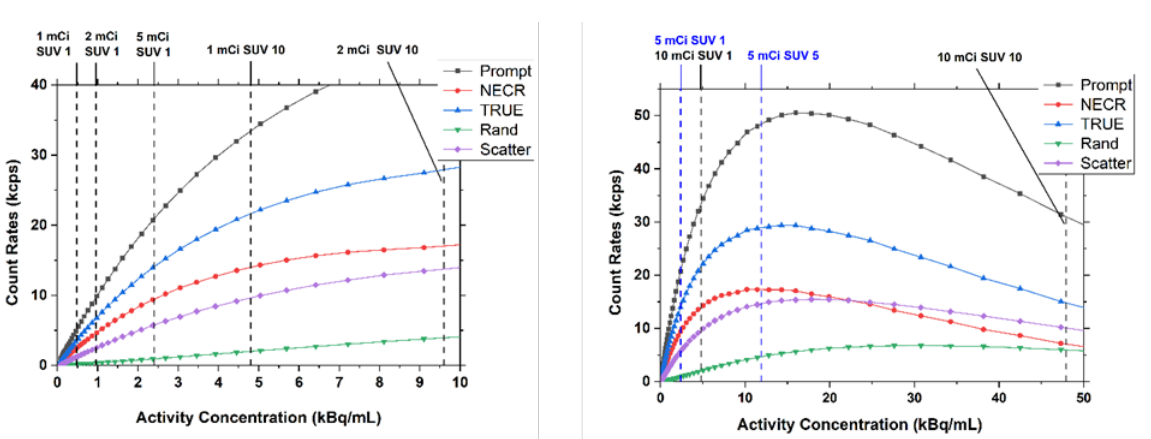
Figure 9. System performance count rates for a 90 mm LOR angle allowance. Left: low range of activity concentrations. Right: full range of activity concentrations. Table 3. Summarized values for count rates at different LOR angle-allowance parameters.